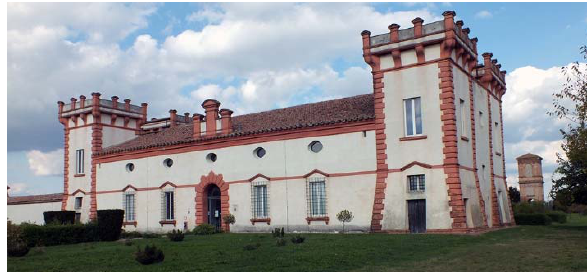
Figure 5: Picture of villa del Verginese